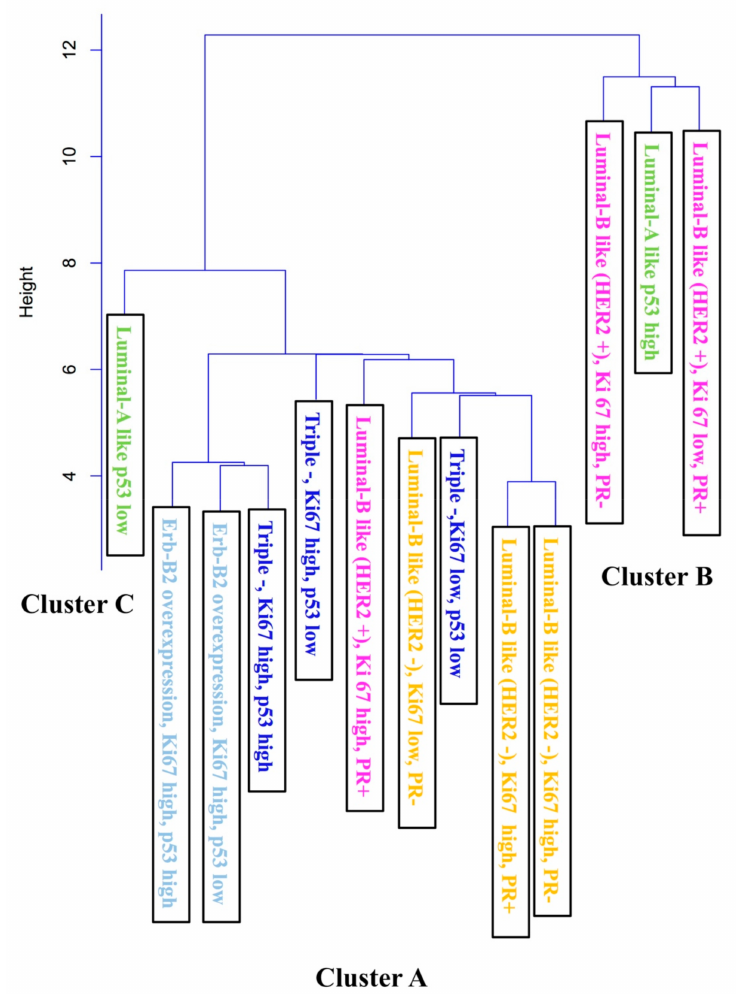
Figure 2. Second Cluster Analysis. Abbreviation: +: positive; -: negative; PR: progesterone receptor; HER2: human epidermal growth factor